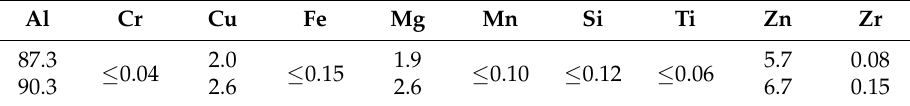
Table 1. Chemical composition for the AA7050 alloy (min − max